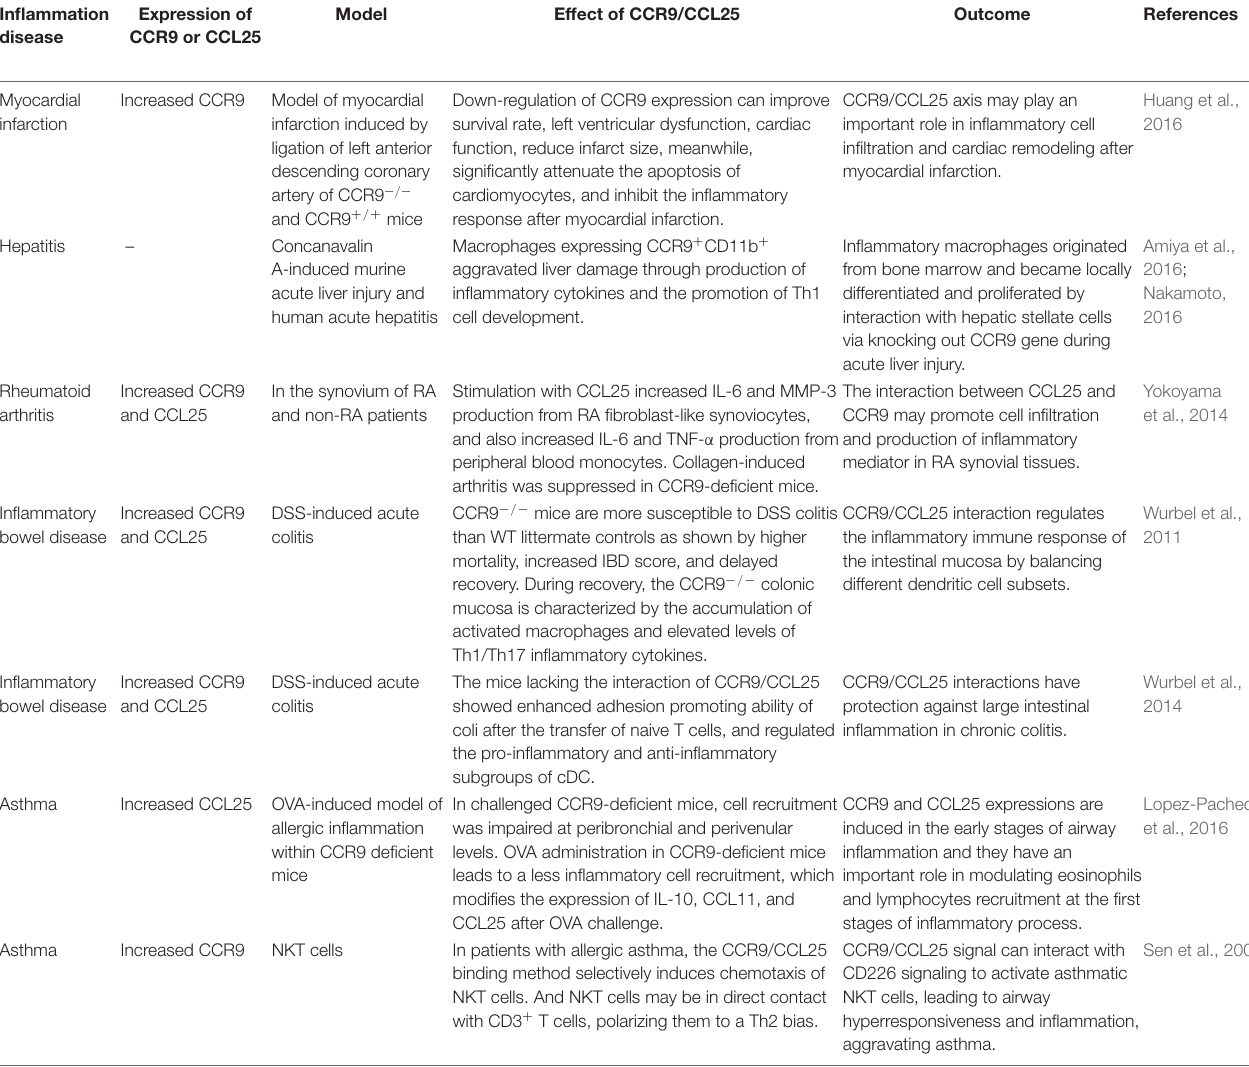
TABLE 2 | The role of CCR9/CCL25 in inflammatory-associated